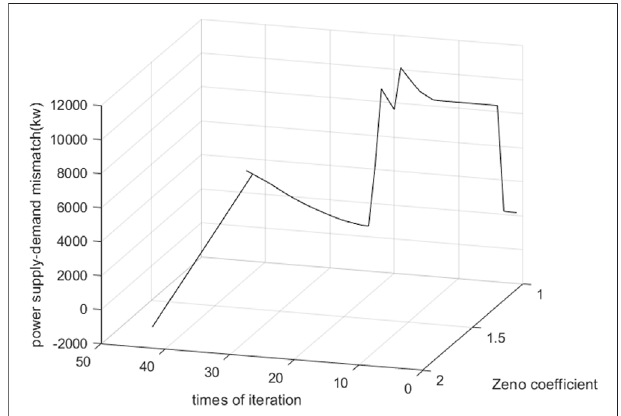
FIGURE 8 | Power supply-demand mismatch.